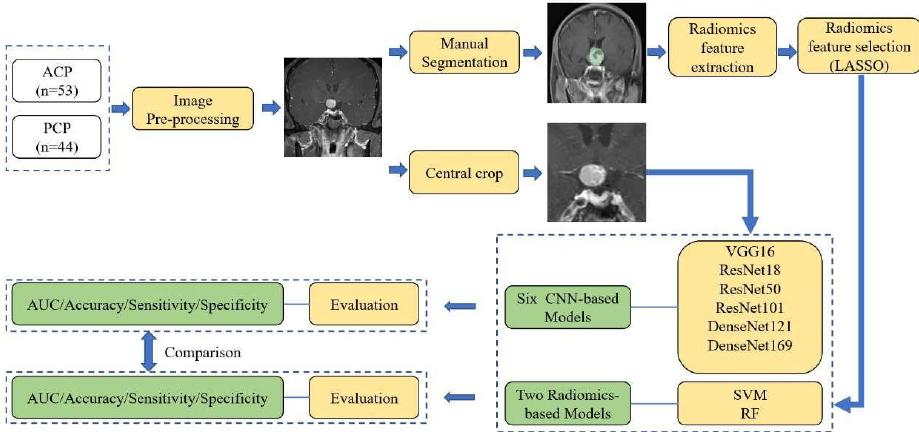
Figure 4. The flow chart of the current research. ACP, adamantinomatous craniopharyngioma; PCP, papillary craniopharyngioma; LASSO, least absolute shrinkage and selection operator; VGG, visual geometry group network; ResNet, residual neural network; DenseNet, densely connected convolutional network; SVM, support vector machine; RF, random forest; CNN, convolutional neural